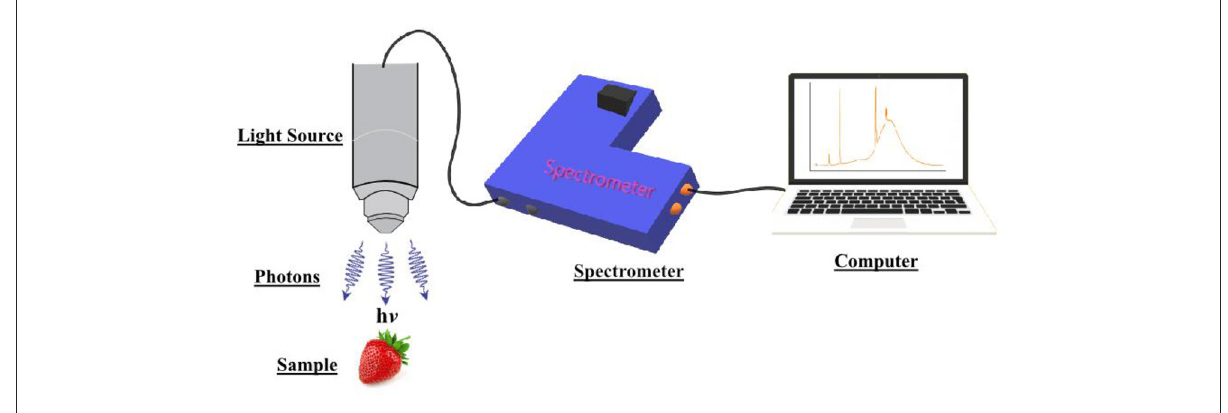
FIGURE1 Spectral data collection